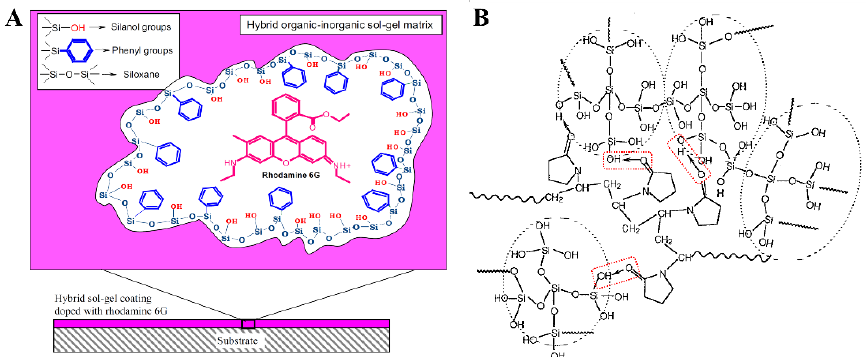
Figure 3. ( A ): Schematic representation of the porous structure of a phenyl modified silica matrix doped with Rhodamine 6G molecules [13]. Reprinted with permission from [13]. Copyright 2015, Nature Springer. ( B ): Structure of PVP-silica hybrid material [15]. Reprinted with permission from [15]. Copyright 1992, Nature Springer.